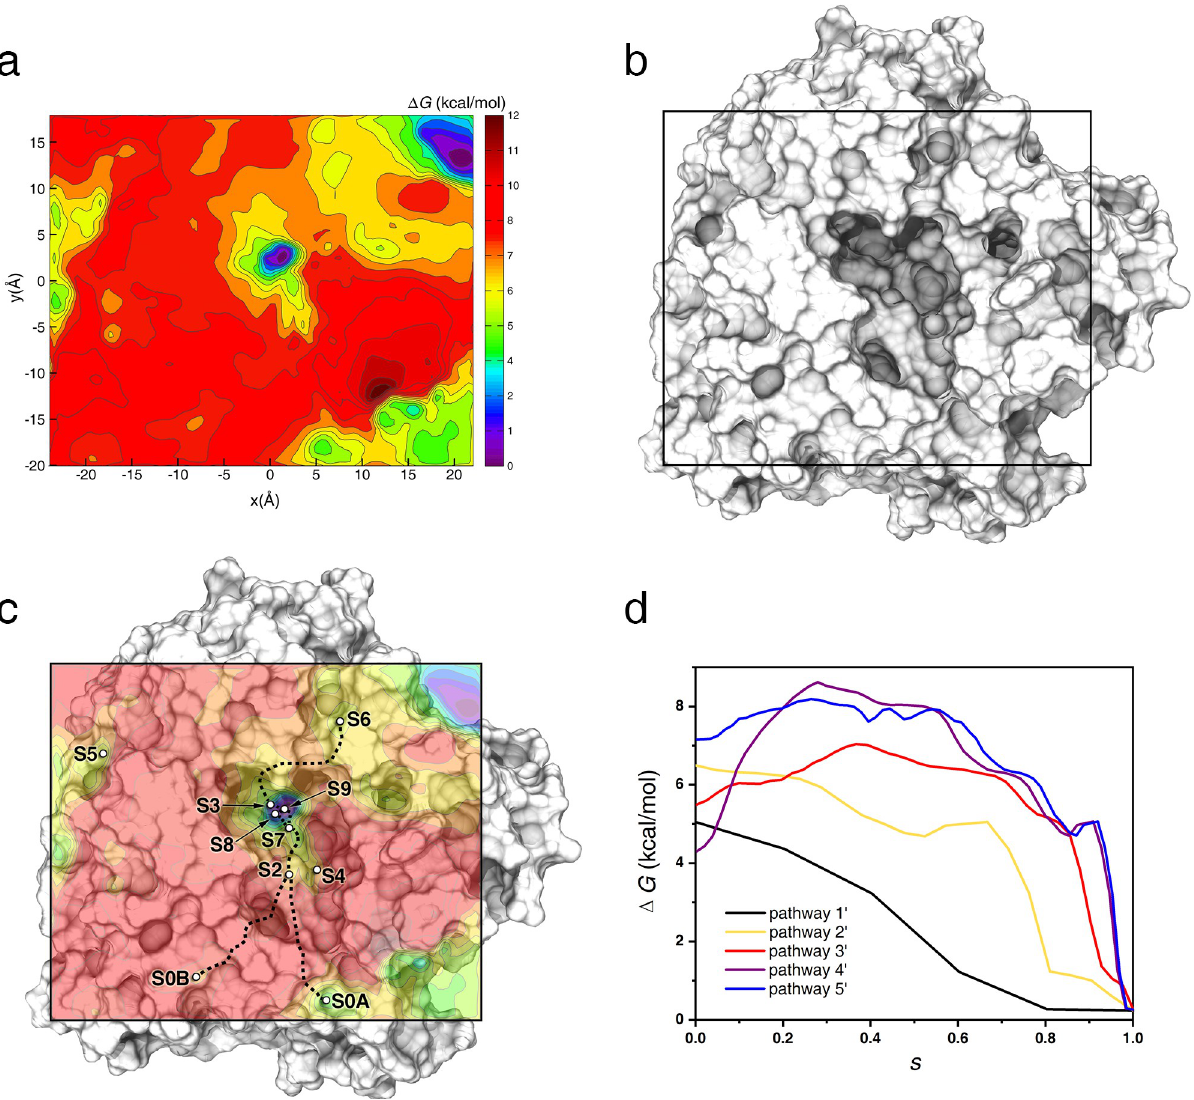
Fig 6. Free-energy landscape and the binding pathways of oseltamivir and NA. (a) Free-energy landscape of oseltamivir along the NA surface. Collective variables x and y represent the projection of the distance vector between the centroids of oseltamivir and NA to the x-axis and y-axis of the system, respectively. The occurrence of the region with very low free energy in the upper right corner of the free-energy landscape will be explained in S1 Appendix, Section 2. (b) Top view of the sampling space of NA in the meta-eABF simulation. (c) Fusion image of NA conformation and free-energy landscape superimposed on Fig 6A and 6B. The metastable states are represented by circles and the pathways connecting the metastable states are shown as dashed lines. (d) Free-energy profiles as a function of the position (s) along the pathways. Pathway 1’: S7 ! S9, pathway 2’: S2 ! S7 ! S8 ! S9, pathway 3’: S6 ! S3 ! S9, pathway 4’: S0A ! S2 ! S7 ! S9, pathway 5’: S0B ! S2 ! S7 ! S9. S = 0.0 in pathways 1, 2, 3, 4 and 5 represents S7, S2, S6, S0A and S0B, respectively, and S = 1.0 in pathways 1, 2, 3, 4 and 5 represents S9.